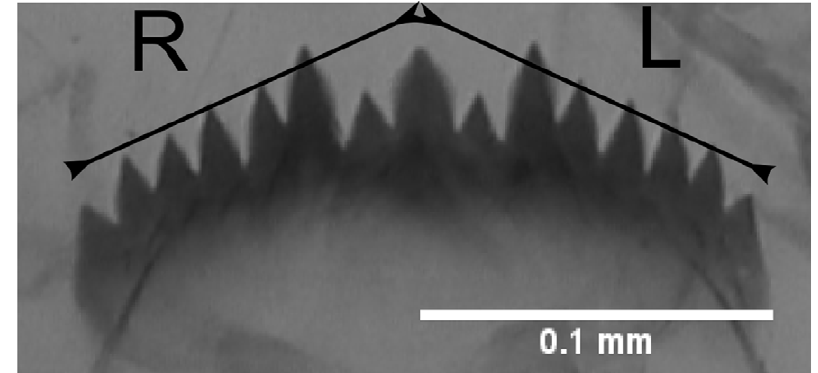
Figure 3. Trait selected to measure length FA.